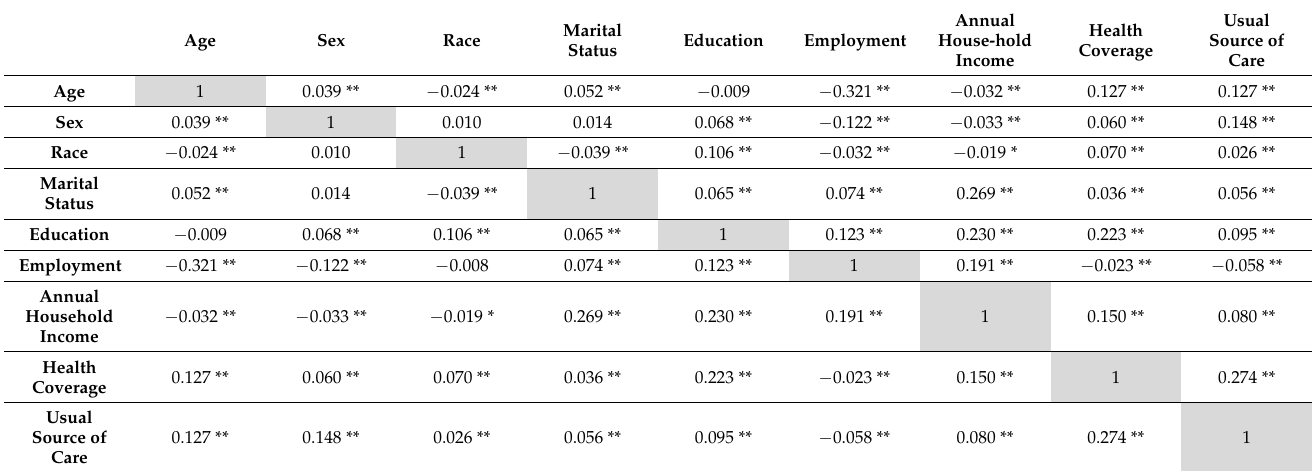
Table 1. Correlation output of independent variables (N = 31,997): NHIS